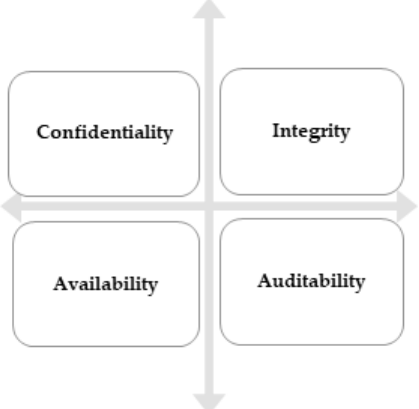
Figure 10. Selected security goals for a manufacturing organization.